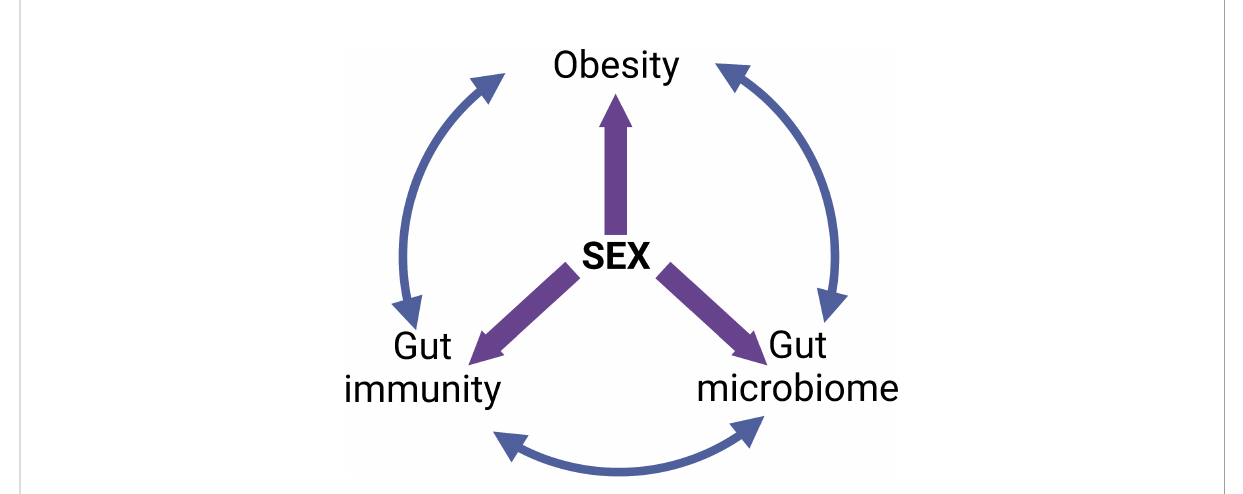
FIGURE 4 The “ give-and-take ” relationships between obesity, intestinal immunity, gut microbiome and sex. Created with